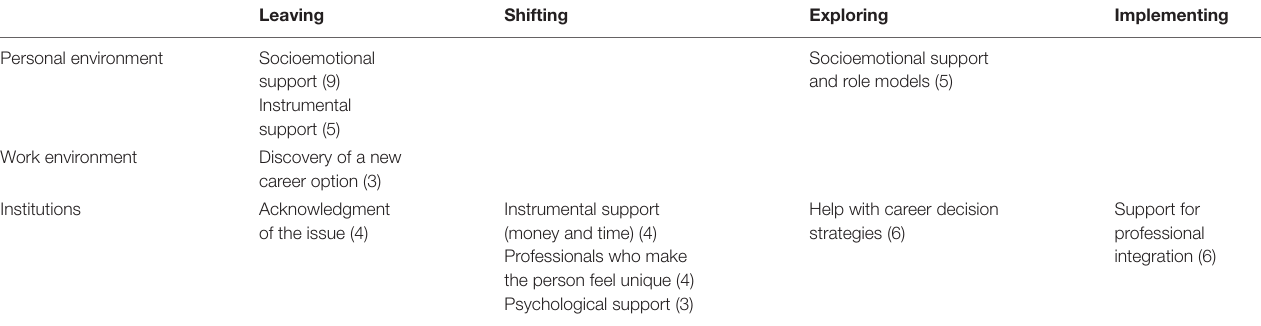
TABLE 2 | Subthemes within positive relational influences. Leaving